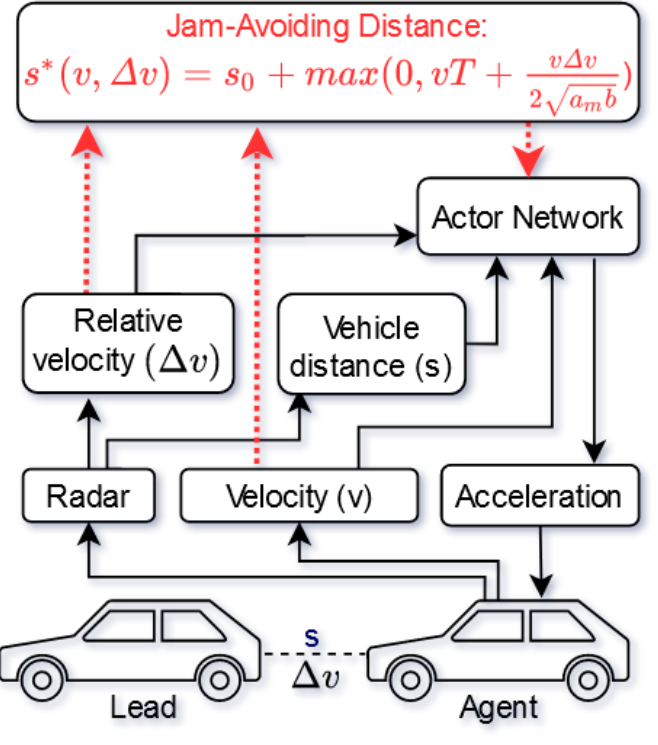
Figure 1. Proposed PG RL approach for increasing the safety of ACC by integrating prior knowledge in the form of the Jam-Avoiding